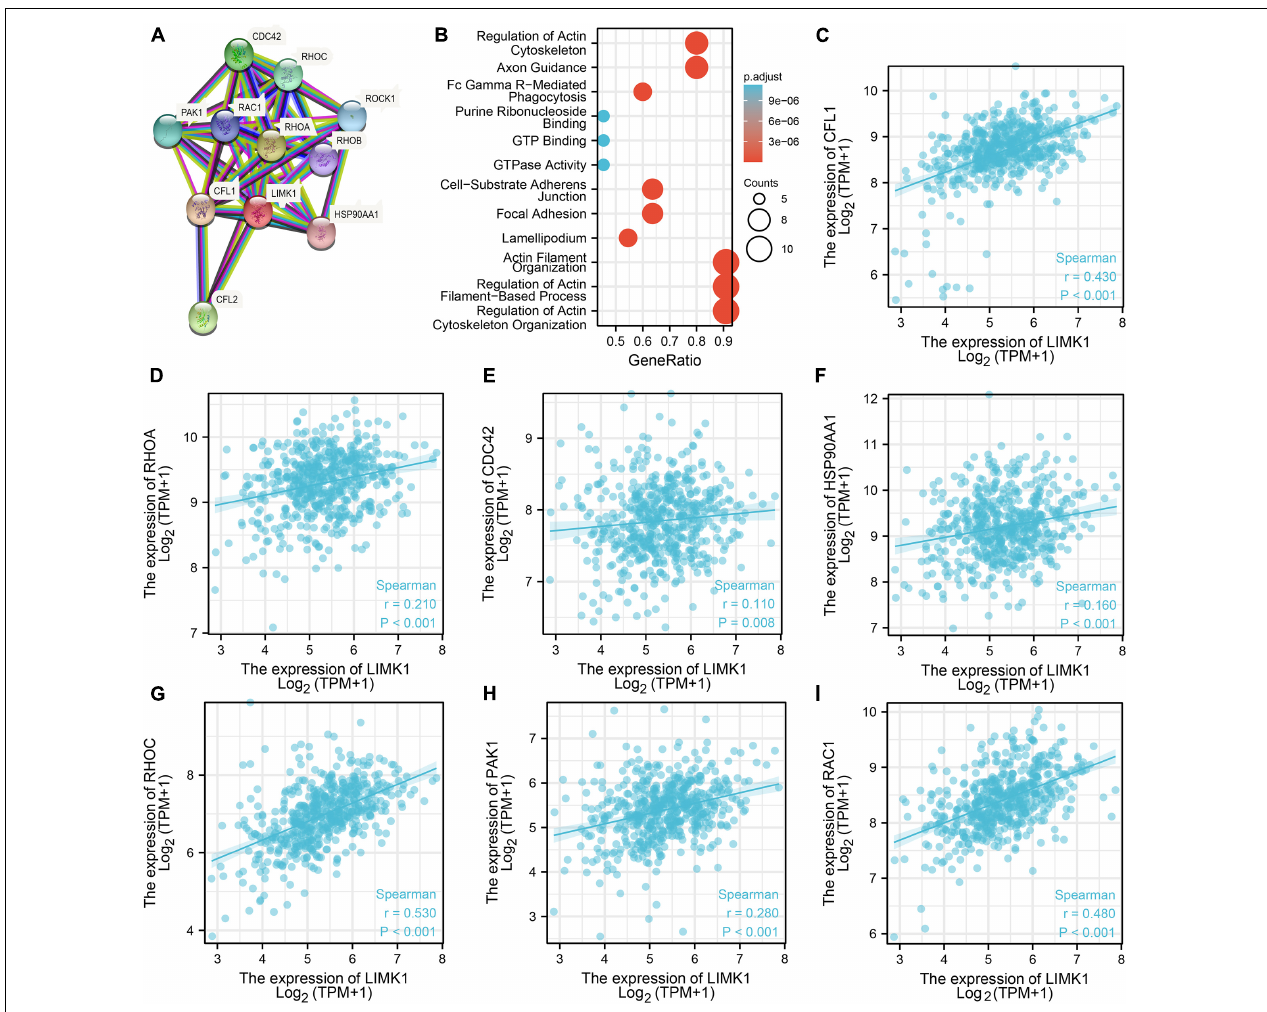
FIGURE 5 | PPI networks and functional enrichment analyses. (A ) A network of LIMK1 and its co-expression genes. (B) Functional enrichment analyses of 11 involved genes. LIMK1 was associated with actin filament organization, regulation of actin filament-based process, and actin cytoskeleton organization. These genes were involved in purine ribonucleoside binding, GTP Binding, and GTPase Activity. (C–I) The correlation analyses between the expression of LIMK1 and co-expressed genes in lung adenocarcinoma.CFL1, cofilin-1; RHOA, transforming protein RhoA; CFL2, cofilin-2; CDC42, cell division control protein 42 homolog; RHOC, Rho-related GTP-binding protein RhoC; PAK1, serine/threonine-protein kinase PAK 1; ROCK1, Rho-associated protein kinase 1; RAC1, Ras-related C3 botulinum toxin substrate 1; RHOB, Rho-related GTP-binding protein RhoB; HSP90AA1, heat shock protein HSP